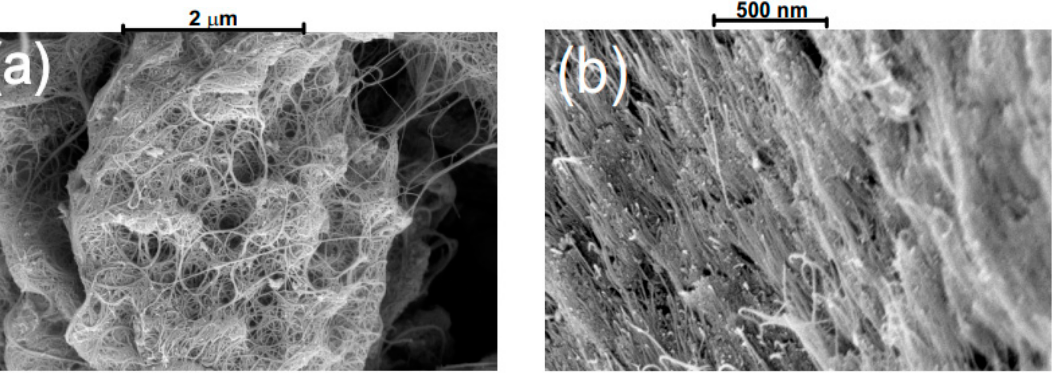
Figure 1. SEM images of ( a ) the initial SWCNTs, and ( b ) after high-pressure high-temperature treatment.